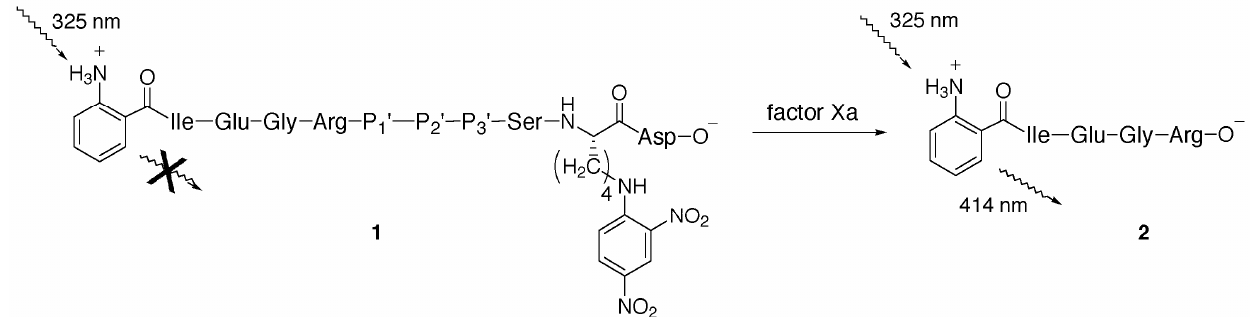
Figure 1. Intramolecular quenching of the Abz fluorophore by the Dnp-lysine residue in the peptidic probes is relieved on cleavage, adjacent to the arginine residue, by the protease, factor